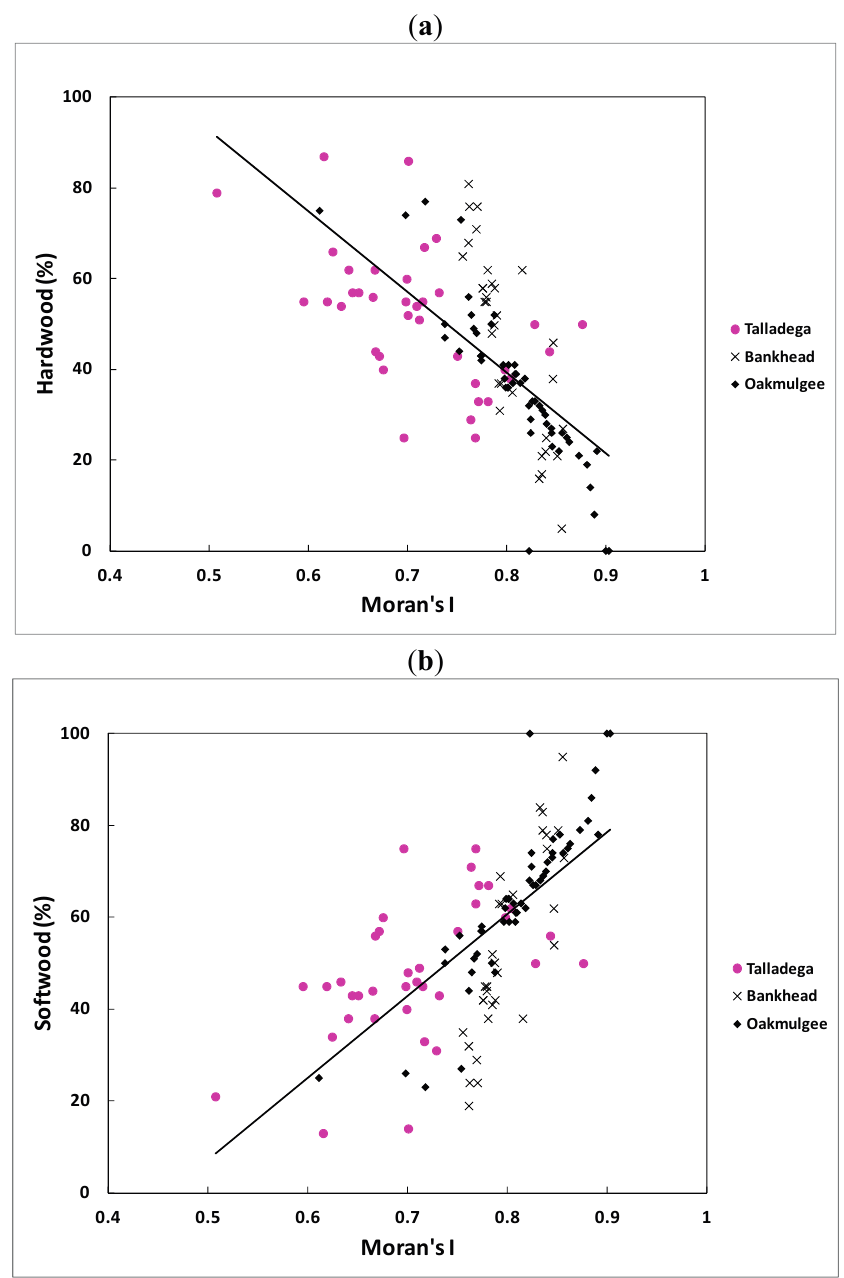
Figure 7. Linear regression prediction models using Moran’s I: ( a ) Hardwood, ( b )